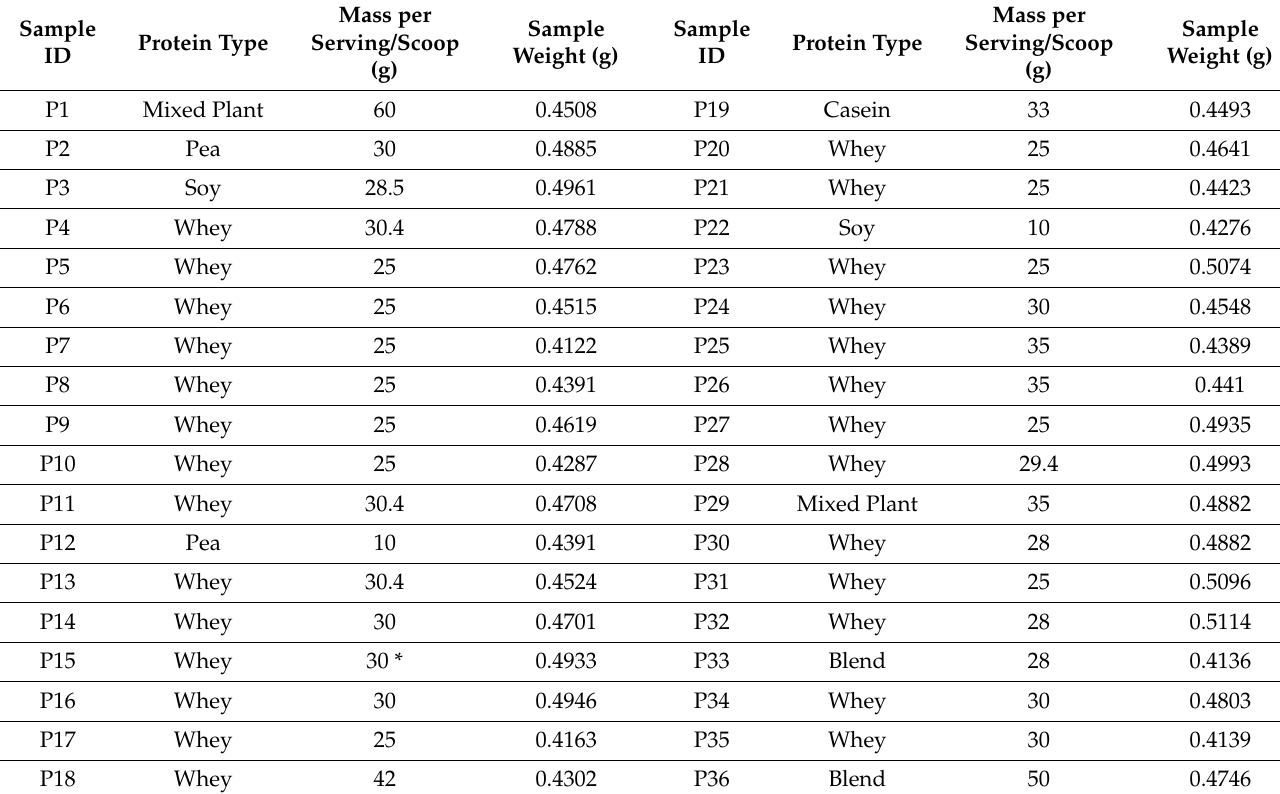
Table 3. Protein powder sample types and